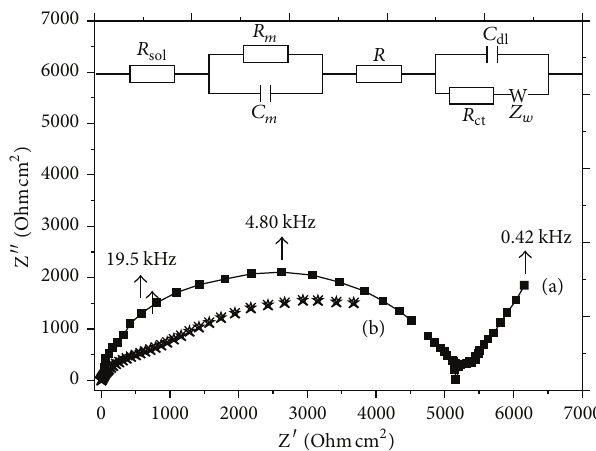
Figure 2: Electrochemical impedance spectroscopy of (a) Pt elec- trode modified with s-BLM and (b) after interaction for 20 min with 5.0 g/L of fructooligosaccharides from chicory in 1mol/L Fe ( CN ) 64−/3− solution containing 0.1mol/L KCl. Inset: modified Randles equivalent circuit presenting the fitting curve. 𝑅 the electrolyte resistance, 𝑅 𝑚 denotes the lipid membrane resistance, 𝐶 𝑚 denotes the lipid membrane capacitance, layer capacitance, 𝑅 is resistance of the monolayer defects, 𝑅 denotes the charge-transfer resistance, and 𝑍 𝑤 denotes the Warburg